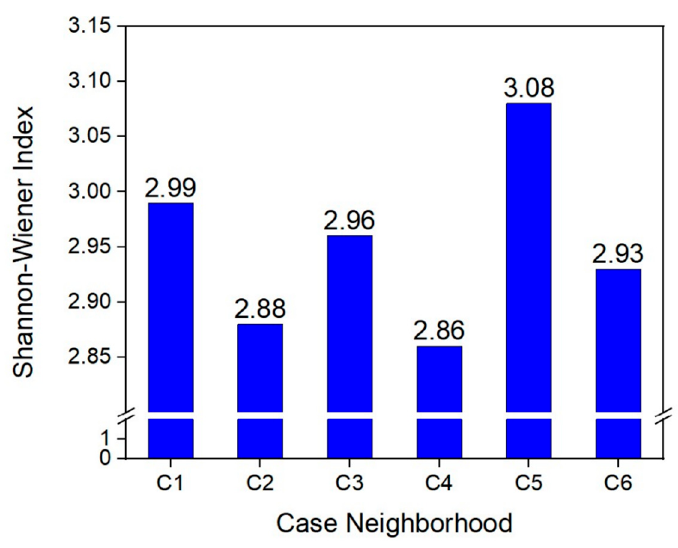
Figure 4. The plant diversity in the six neighborhoods.